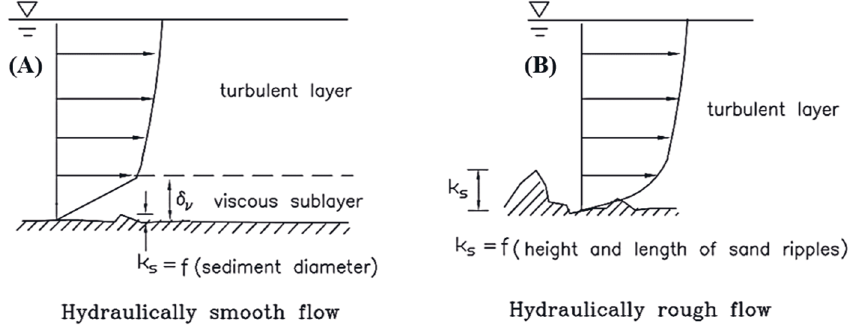
Figure 1. ( A ) Universal velocity distribution for turbulent layers near smooth walls; ( B ) Universal velocity distribution for turbulent layers near rough walls (modified from Liu